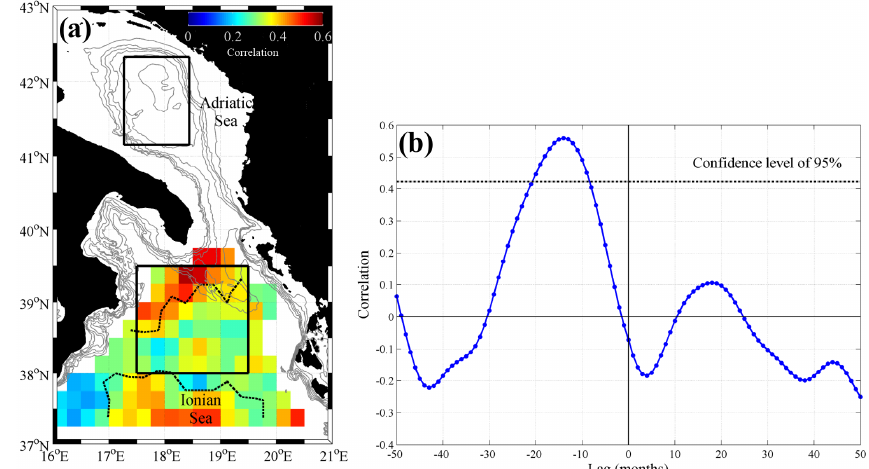
Figure 4. Correlation between the time series of the spatially averaged low-pass current vorticity in the Adriatic and 0 . 25 ◦ × 0 . 25 ◦ domains in the Ionian for the 14-month time lag (a) ; lagged correlation between Adriatic and Ionian spatially averaged vorticities. For the Adriatic the averaging domain is the upper polygon while for the northern Ionian the averaging domain corresponds to the area (0 . 25 ◦ × 0 . 25 ◦ ) with the maximum correlation (b) ; the black polygons show the areas used to estimate the time series in Fig. 2; the black dotted lines indicate the level of confidence of